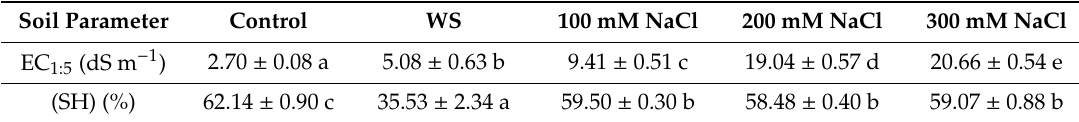
Table 1. Electric conductivity (EC) of the substrate, in a 1:5 soil suspension (EC 1:5 ), and soil humidity (SH) on the pots of A. alba seedlings after 30 days of water deficit (WS) and salt stress (100, 200 and 300 mM NaCl) treatments 1